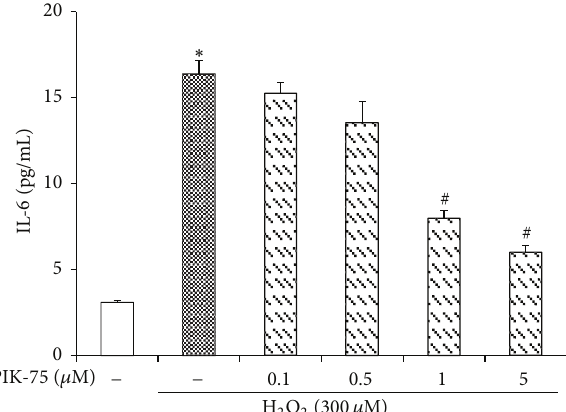
Figure 8: Effect of PIK-75 on IL-6 release in feline EECs stimulated by H 2 O 2 . Serum-starved EECs were preincubated in the presence of PIK-75. EECs were then stimulated with H 2 O 2 (300 𝜇 M, 6 hours). The production of IL-6 was measured in supernatants by ELISA. Data are expressed as means ± S.E of four experiments (Student’s t -test; ∗ 𝑃 < 0.05 versus control, # 𝑃 < 0.05 versus H 2 O 2